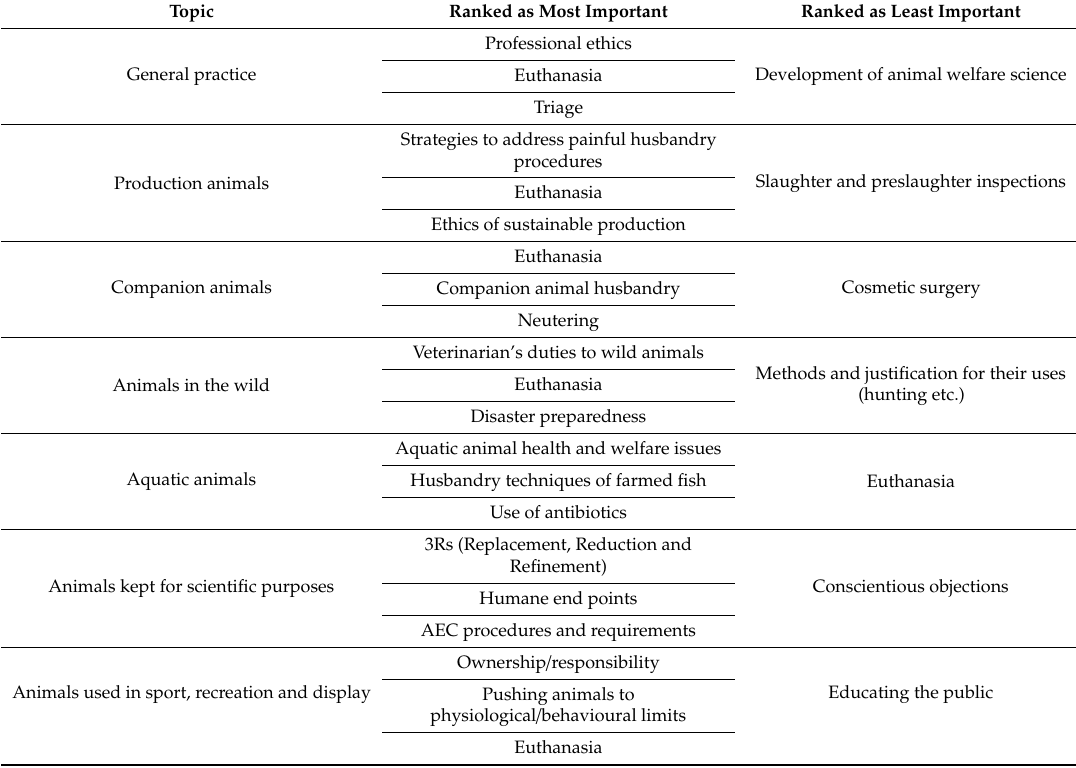
Table 4. Educators’ ( n = 142) ranking of importance of Day One